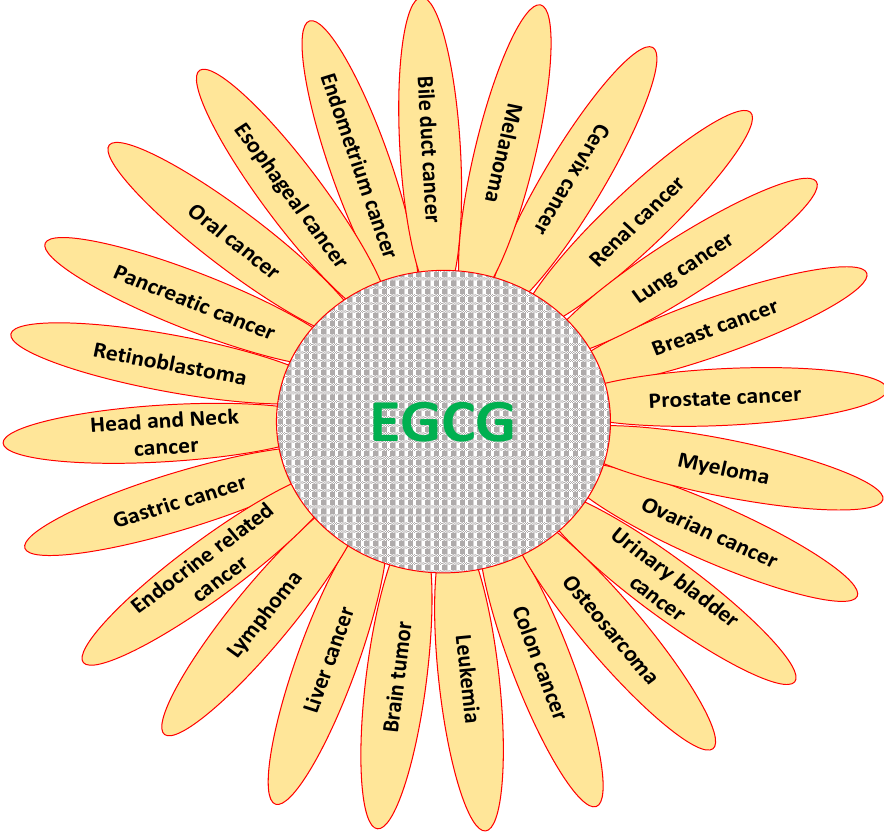
Figure 4. Role of EGCG in inhibition of numerous types of cancers.